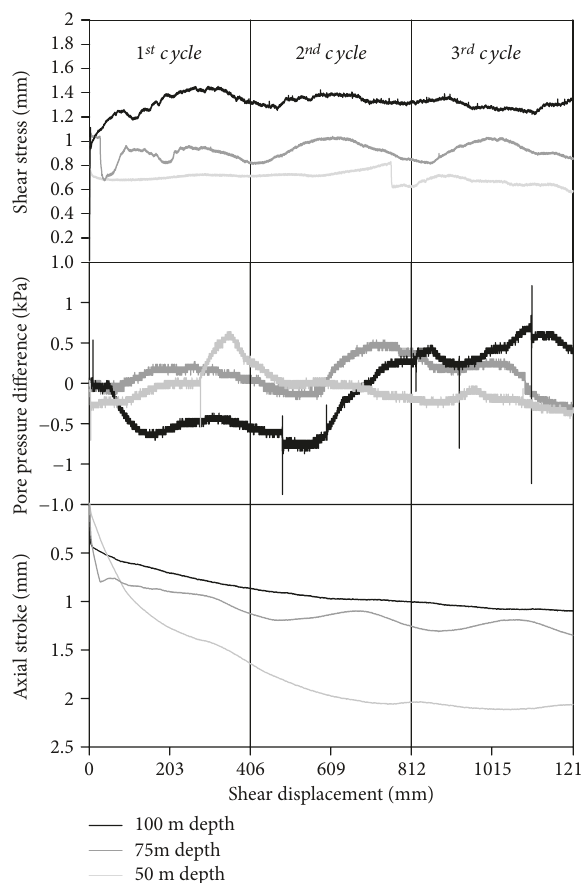
Figure 9: Experimental results of CU ring shear